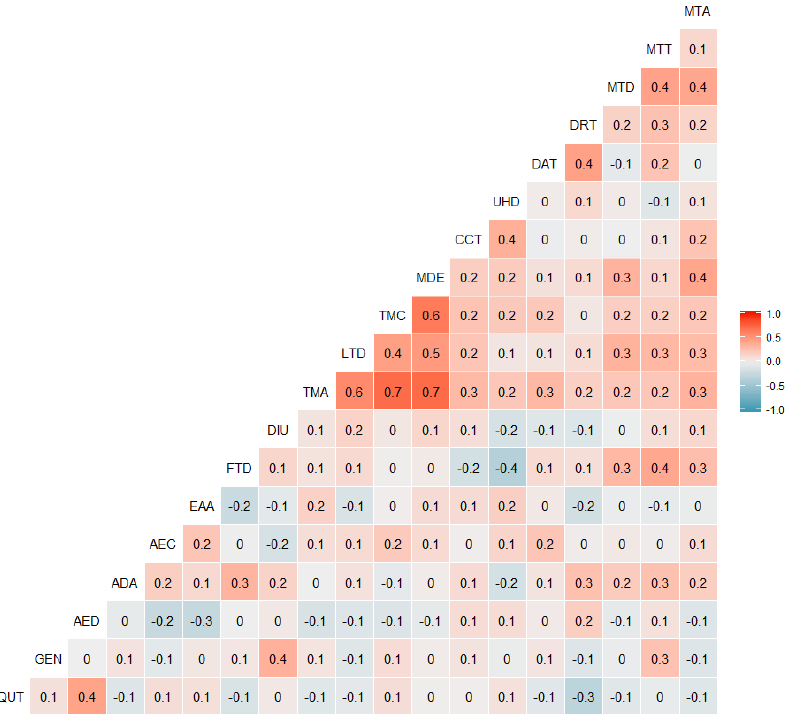
Figure 1. Correlations between the variables of the study.